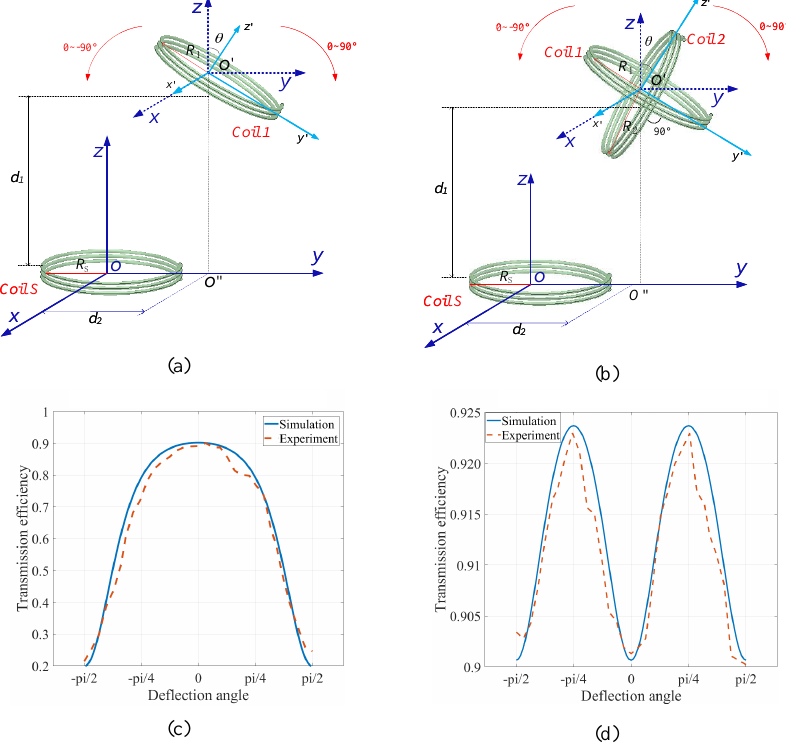
Figure 10. The transmission characteristics of receiver with one coil and two coils vary with offset distance. ( a , b ) are the diagrammatic sketch of the one-coil-receiver system and two-coils-receiver system, respectively. ( c , d ) show the transmission efficiency of one-coil-receiver system and two-coils- receiver system vary with deflection angle θ , respectively. In both systems, the pitch rotation angle γ = 0 , R = 10 cm, N = 11, d 1 = 15 cm, d 2 = 0. The simulation is completed by